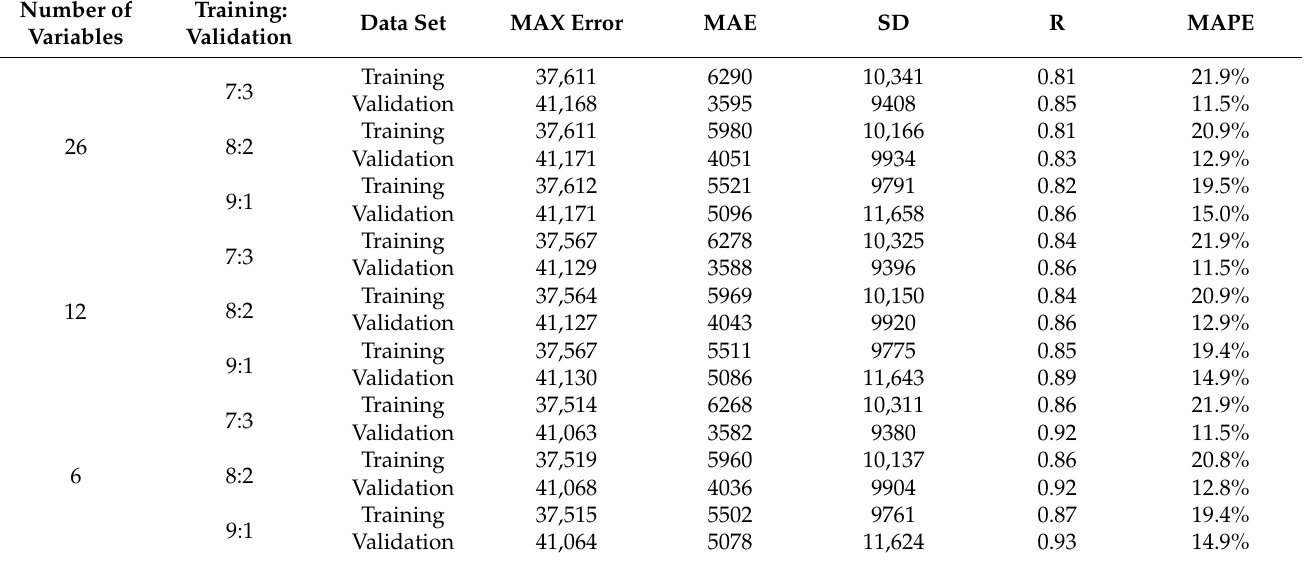
Table A3. Analysis of the results of the SVM model for electricity consumption.